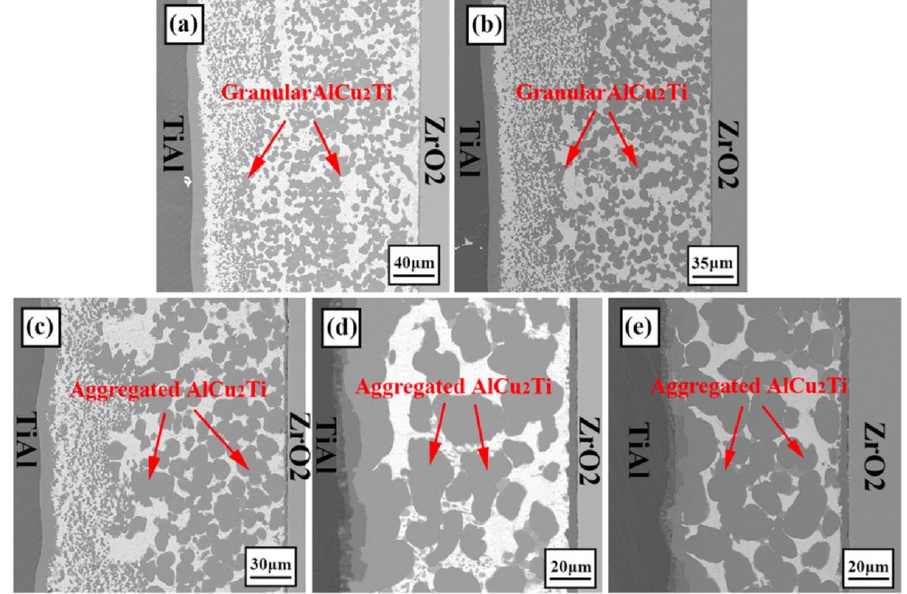
Figure 7. Microstructures of TiAl/AgCu/ ZrO 2 joints produced at 880 °C for different holding times: ( a ) 5 min; ( b ) 10 min; ( c ) 15 min; ( d ) 20 min and ( e ) 25 min, reproduced from Reference [28] with permission of Elsevier, 2015.